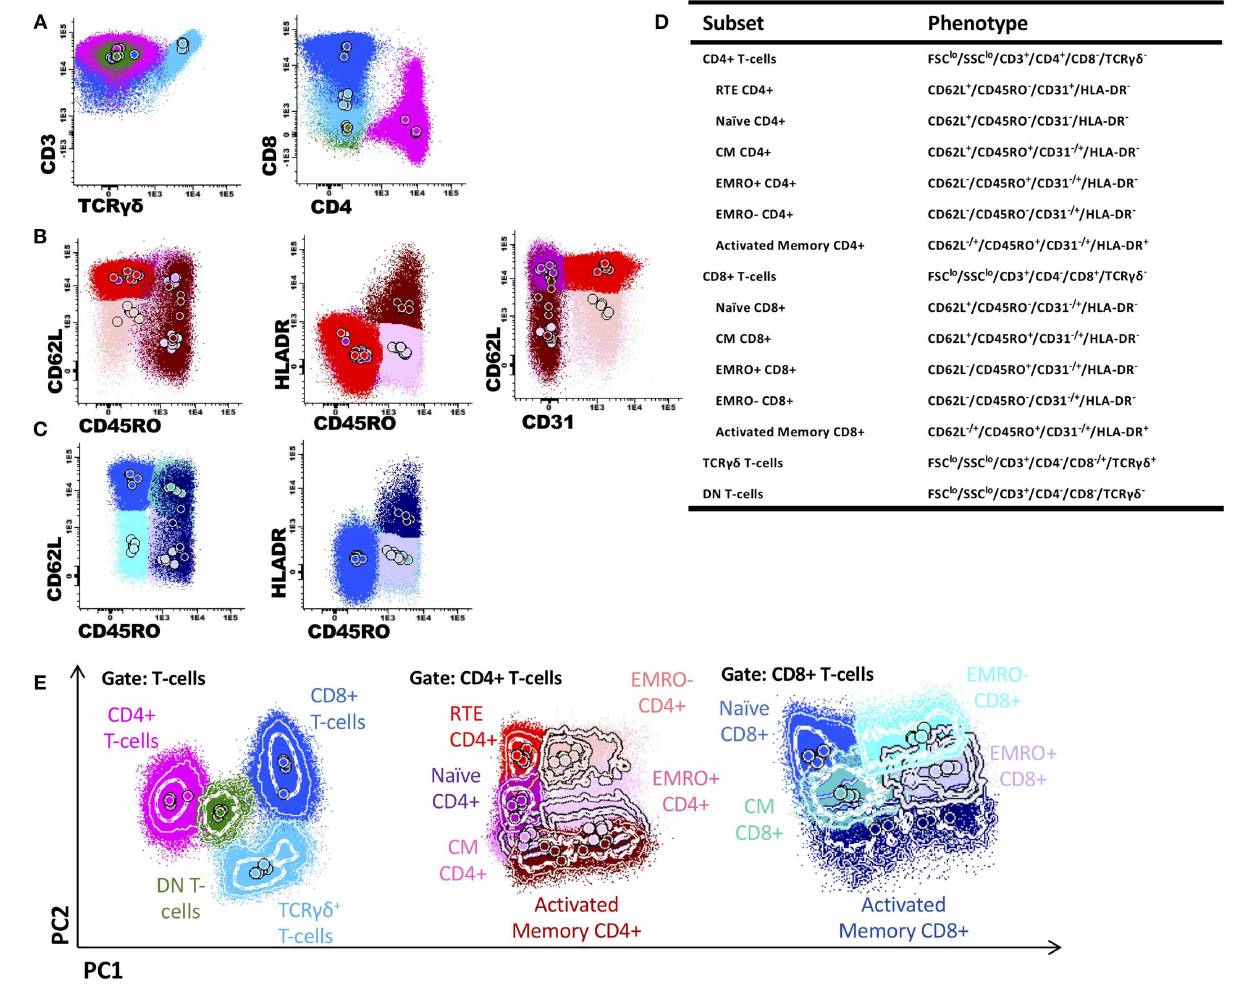
FIGURE 1 | Gating T-cell subsets and generation of a reference principal component analysis representation in an n-dimensional space for SCID-RTE tube. (A) After gating T-cells as CD3 + and FSC lo and SSC lo , the markers TCR γδ + , in combination with CD4 and CD8 were used to define TCR γδ + T-cells (light blue), CD4 + CD8-TCR γδ - T-cells (pink); CD4-CD8 + TCR γδ - T-cells (dark blue) and CD4-CD8- TCR γδ - double negative T-cells (green). (B) The CD4 + T-cell subsets were further subdivided into recent thymic emigrants (RTE; CD62L + CD45RO-HLDR-CD31 + ; red), naïve (CD62L + CD45RO-HLDR-CD31-; purple), central memory (CM; CD62L + CD45RO + HLDR-; orchid), effector memory CD45RO + (EMRO + ; CD62L-CD45RO + HLDR-; mauve), effector memory CD45RO- (EMRO-; CD62L-CD45RO-HLDR-; pink) and activated memory (CD45RO + HLDR + ; burgundy) CD4 + T cells. (C) The CD8 + T-cell maturation subsets were further